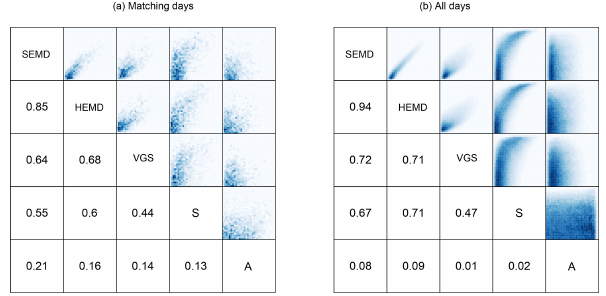
Figure 11. Lower triangle: correlations between the absolute values of all scores, calculated over (a) the 20 × 127 pairs belonging to matching days and (b) all 20 × 127 × 127 combinations of forecast and observation. The upper triangles show bi-variate histograms for all combinations of